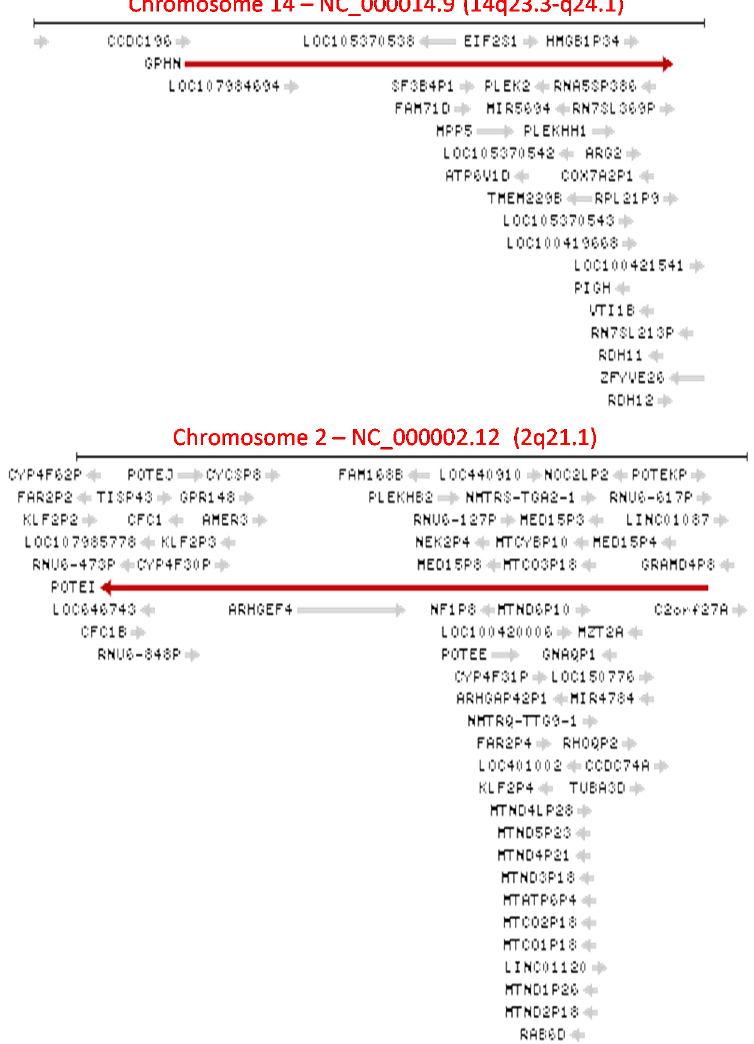
Figure 1. Images copied from the National Center for Bioinformation of the United States (NCBI) database illustrating that some human genomic loci are crowded gene habitats. Within the GPHN gene (the long red arrow in the top image) on the plus DNA strand (arrow to the right) of the 14q23.3–24.1 region, there are also many other genes encoded not only by the same plus strand (short grey arrows to the right) but also by the minus strand (short grey arrows to the left). Similarly, within the POTEI gene (the long red arrow in the bottom image) on the minus DNA strand (arrow to the left) of the 2q21.1 region, there are also many other genes encoded not only by the same minus strand (short grey arrows to the left) but also by the plus strand (short grey arrows to the right). Some of these genes are temporarily annotated with “LOC” (locus) and a number, since they have not yet been characterized.